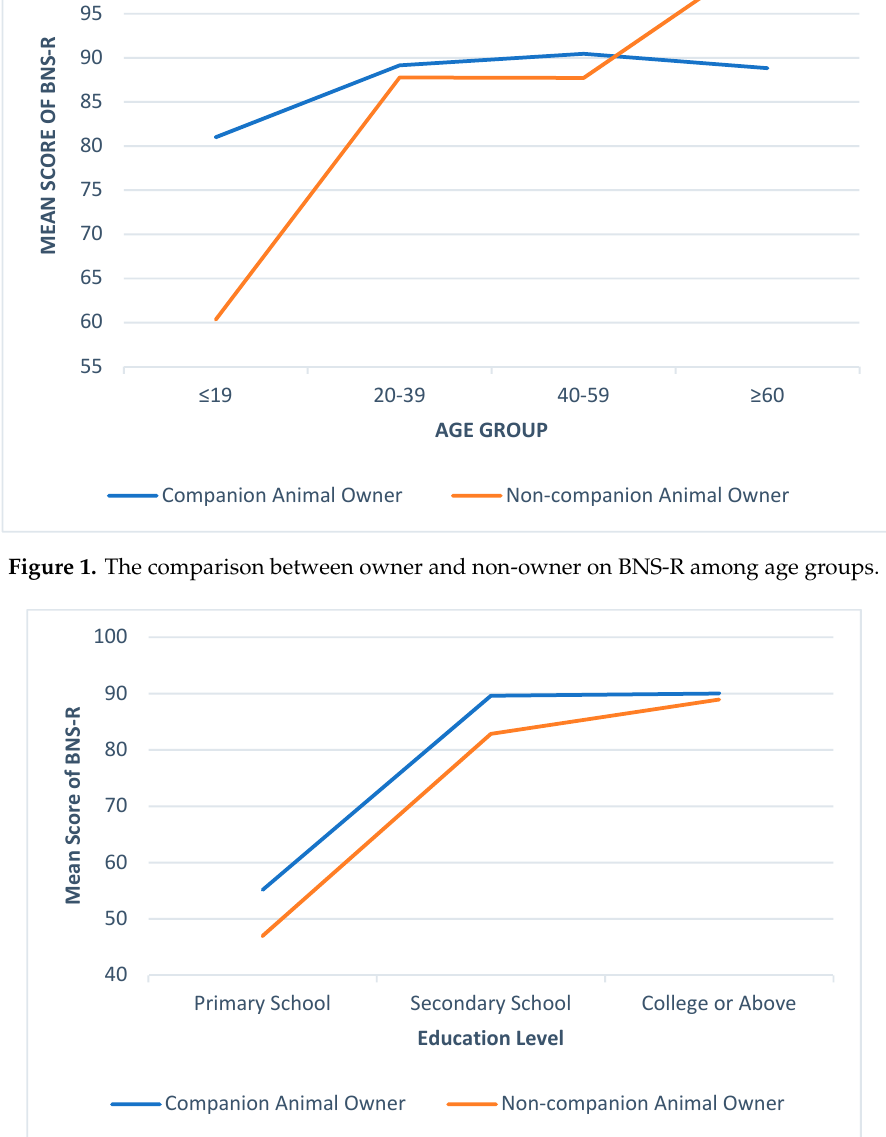
Table 6. Descriptive statistics on BNS-R among education level by ownership status.